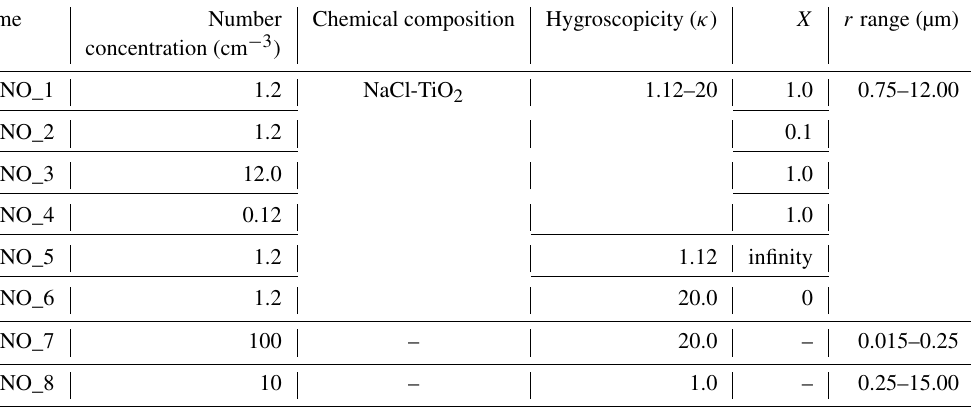
Table 2. Characteristics of the nanoparticles. Because the shape of the size distribution function is the same in the NANO_1–NANO_6 cases, only the NANO_1 is plotted in Fig. 2b. The mode radius is 2.0µm in these cases. The meaning of X can be found in Eq. (5). NANO_7 and NANO_8 are hypothetical particles for the sensitivity study with the mode radius of 0.05µm and 2.5µm, respectively (blue and red curves in Fig. 2b).